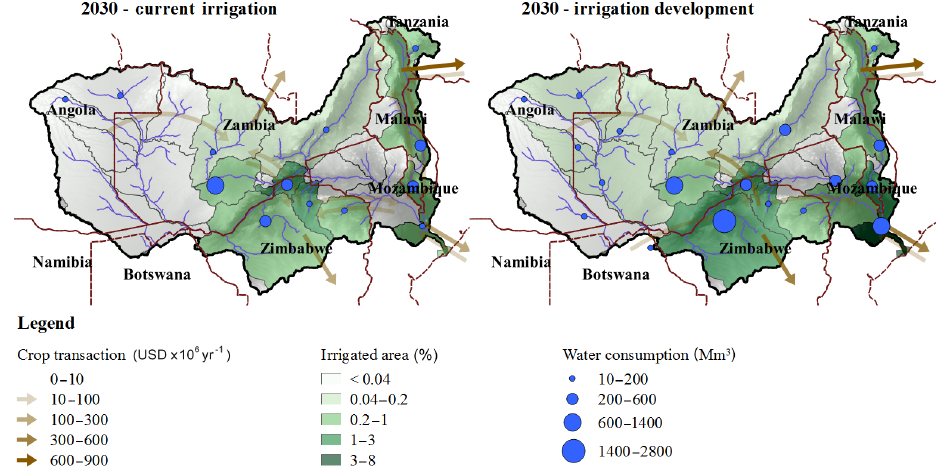
Figure 10. Crop trade and irrigation water consumption before and after the implementation of the irrigation development plan (IDP). Implementation of the IDP is found to increase crop exports to the world market and more than double water consumption. The “crop transactions” towards the exterior of the Zambezi area represent exports to the world market. Table 12. Impacts of the irrigation development plan. Results are shown as the difference with and without the irrigation development plan for the 2010, 2030, and 2050 scenarios. Sector benefits exclude project development costs. Impacts of the irrigation development